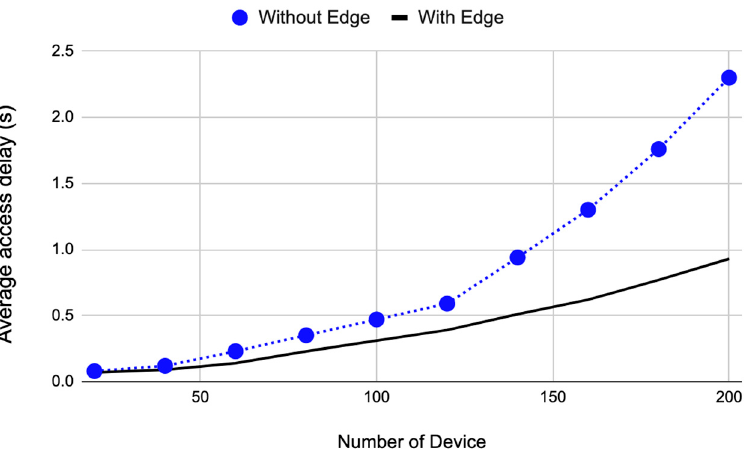
Figure 3. The average access delay against the number of terminal devices for the four configura- tions. The blue line is for configurations 1 and 2 (without edge), and the red line for configurations 3 and 4 (with edge).